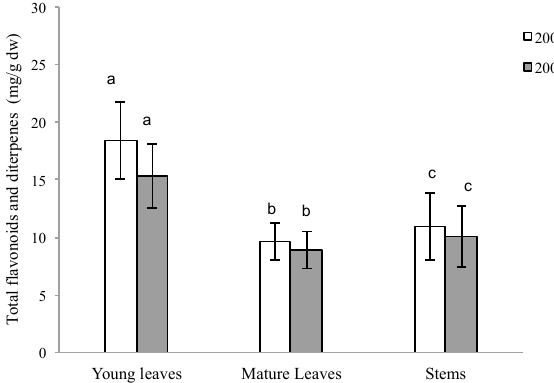
Figure 2. Total flavonoid and diterpene concentrations (mg/g dw) of samples of young and mature leaves and stems within each year of C. ladanifer . Error bars, means, standard deviation. Annual mean ( n = 20 individuals × 3 replicates × 8 seasons = 480). a, b, c : different letters mean significant differences between young and mature leaves and steams p < 0.05 (Wilcoxon Test).